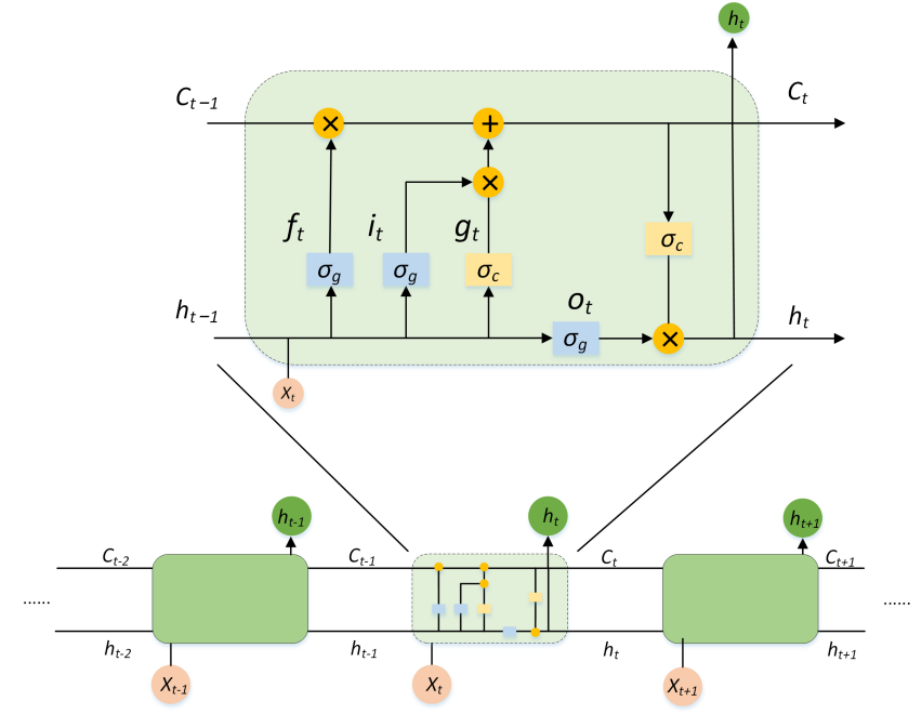
Figure 4. Structure of an LSTM memory cell.